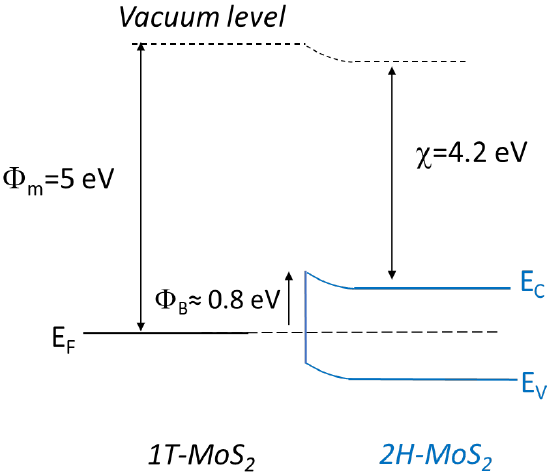
Figure 10. Schematic energy band diagram of a 1T-MoS 2 / 2H-MoS 2 lateral heterojunction [62].